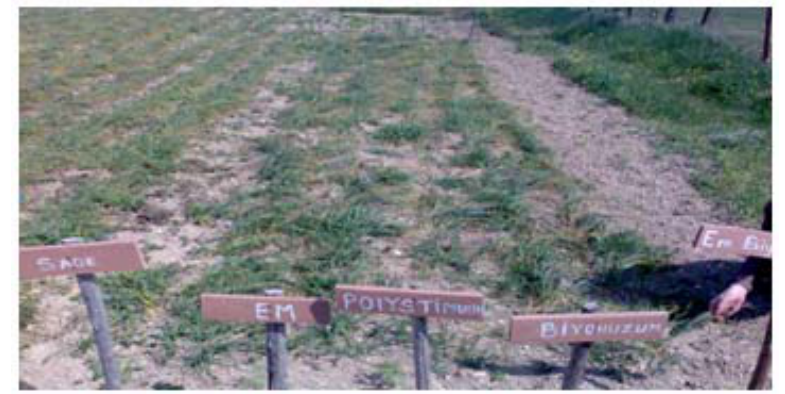
Figure 6. View of the test